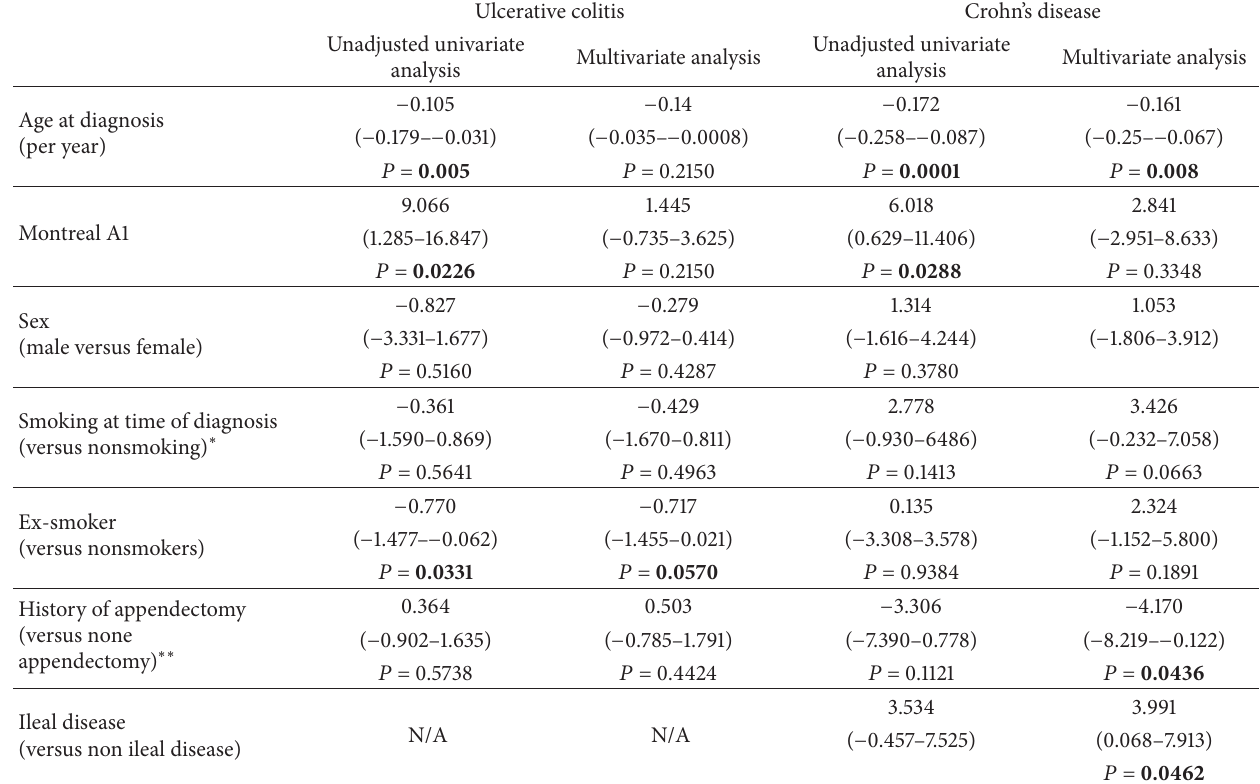
Table 3: Regression analysis of %BMI change prior to diagnosis in CD/UC